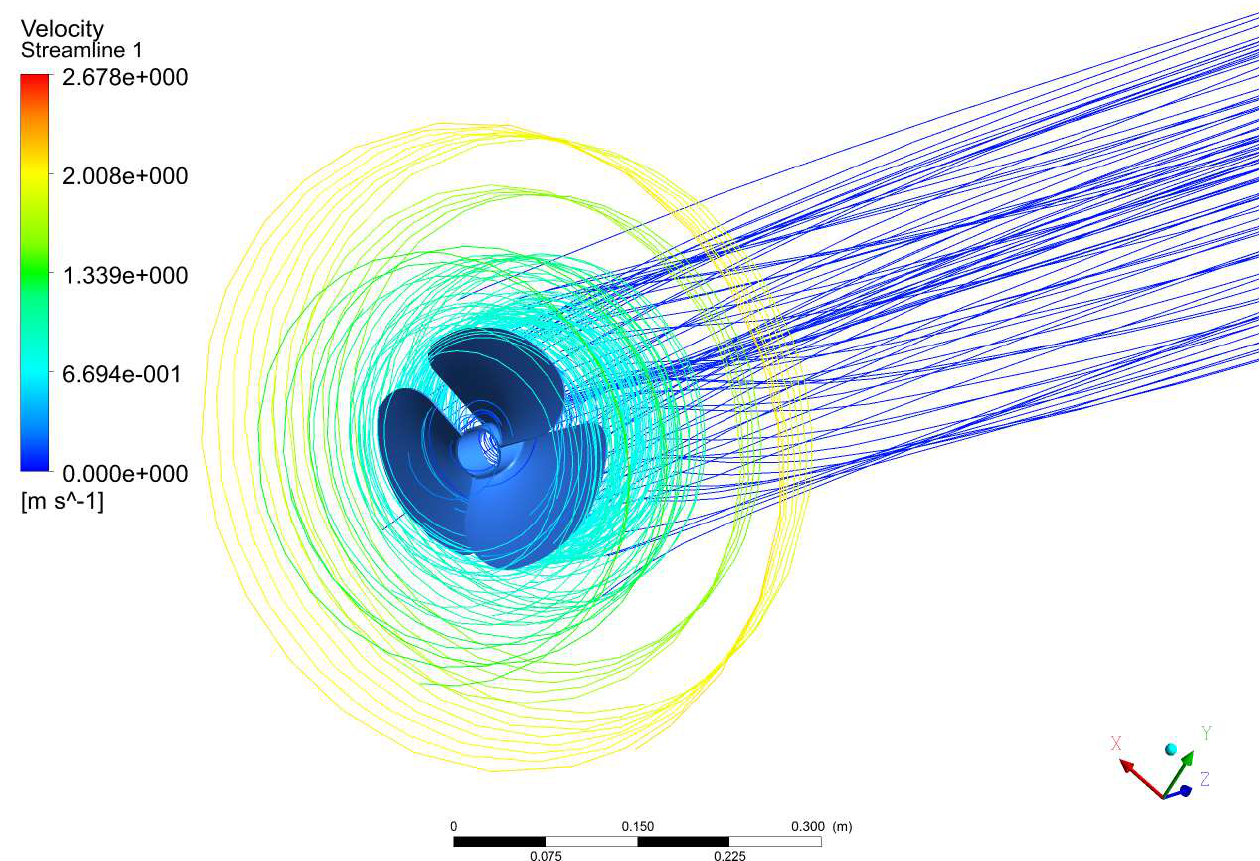
Figure 15. Velocity variations of 75 RPM.